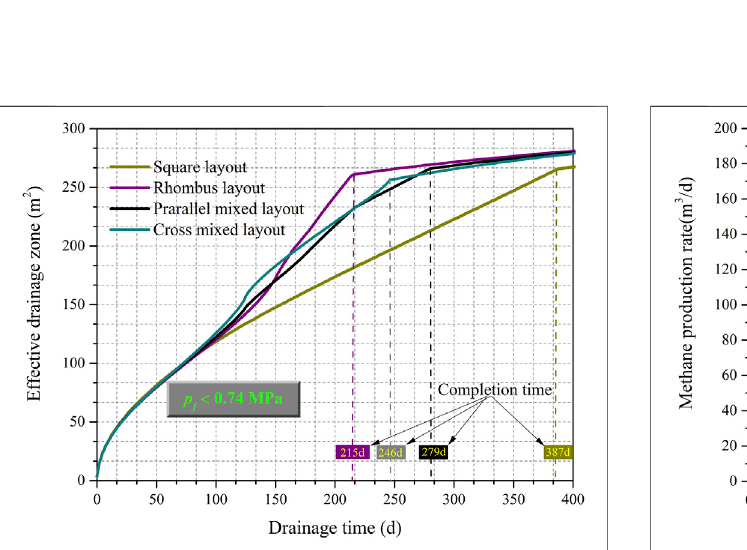
FIGURE 7 | Methane production rates vs. drainage